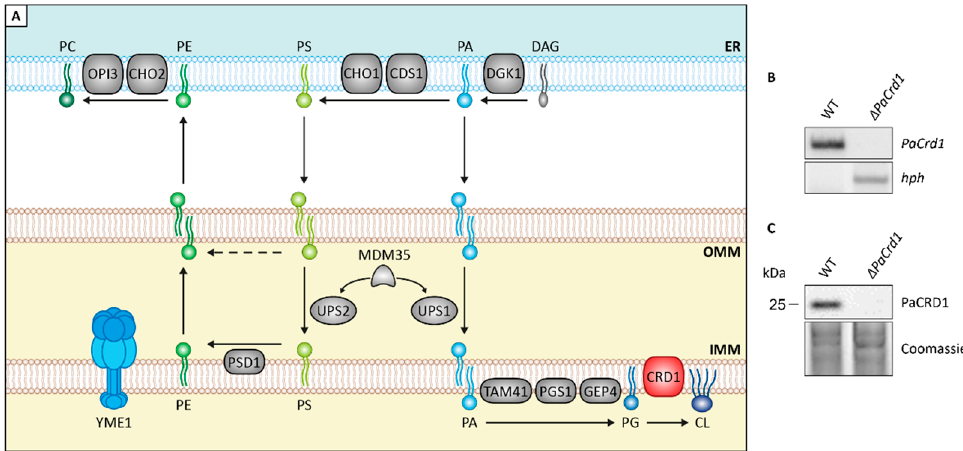
Figure 2. Genetic modulation of PL homeostasis. ( A ): Scheme depicting major components of